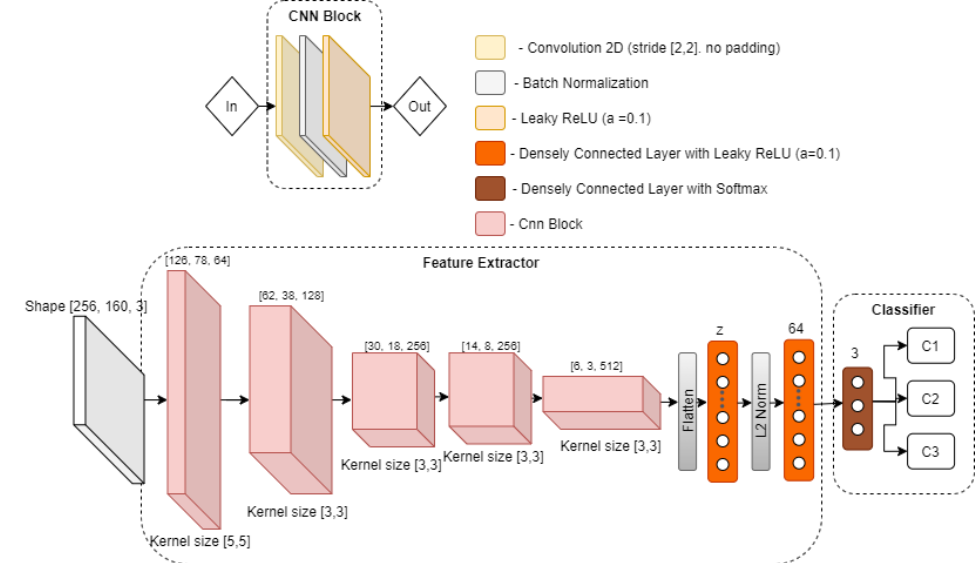
Figure 5. CNN feature extractor